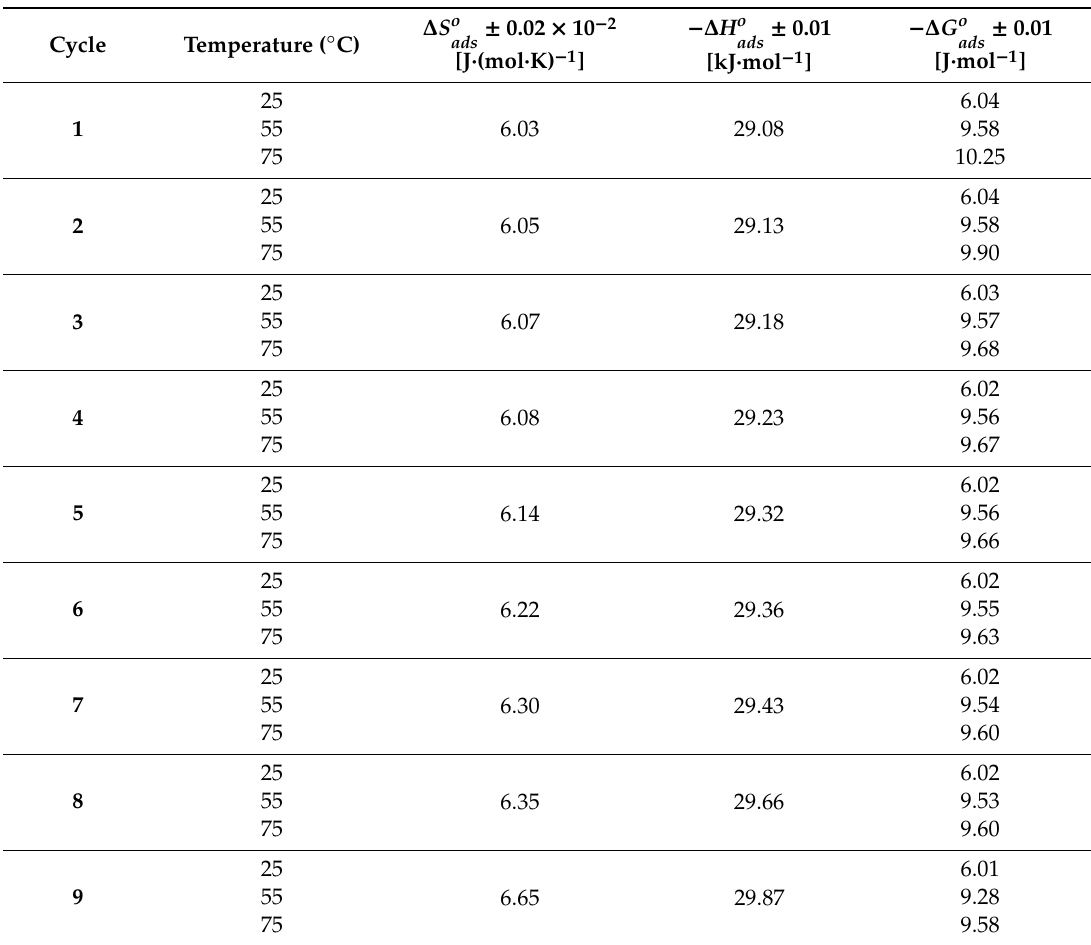
Table 3. Thermodynamic parameters for the adsorption of n -C 7 asphaltene onto CeNi0.89Pd1.1 nanoparticles through di ff erent catalyst regeneration cycles of adsorption and subsequent catalytic steam gasification. The change in entropy is expressed by ∆ S o , change in enthalpy is ∆ H o and ads ads change in Gibbs free energy is ∆ G o ads